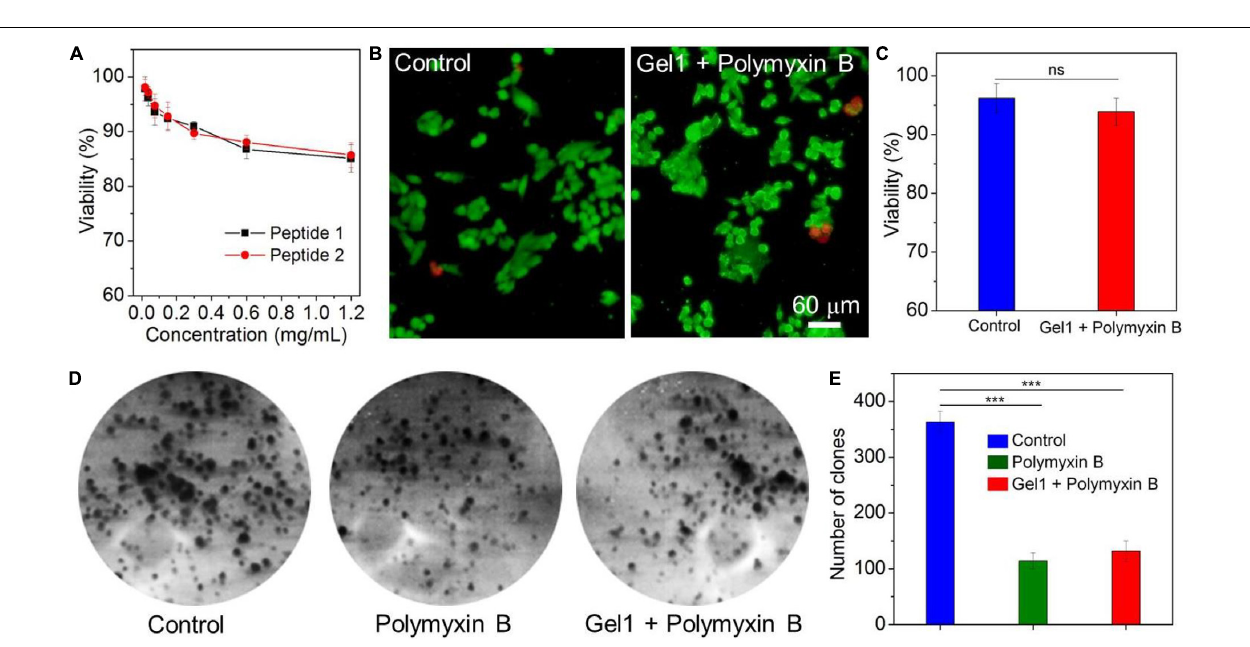
FIGURE 5 | (A) Viability of NIH/3T3 fibroblasts incubated with the amphiphilic peptides at different concentrations for 24 h. (B) Live-dead assay of NIH/3T3 fibroblasts seeded in blank cell culture plate (Control) or on the surface of Gel1 loading polymyxin B followed by cultured with DMEM containing 10% FBS for 24 h. The live cells were stained with calcein AM as green fluorescence and dead cells were stained with EthD-1 as red fluorescence. (C) Viability of NIH/3T3 fibroblasts quantified from panel (B) . (D,E) Clone formation (D) and number of clones (E) of E. coli treated with free polymyxin B or Gel1 loading polymyxin B. E. coli incubated in blank culture plate was used control. ** P < 0.01, *** P <